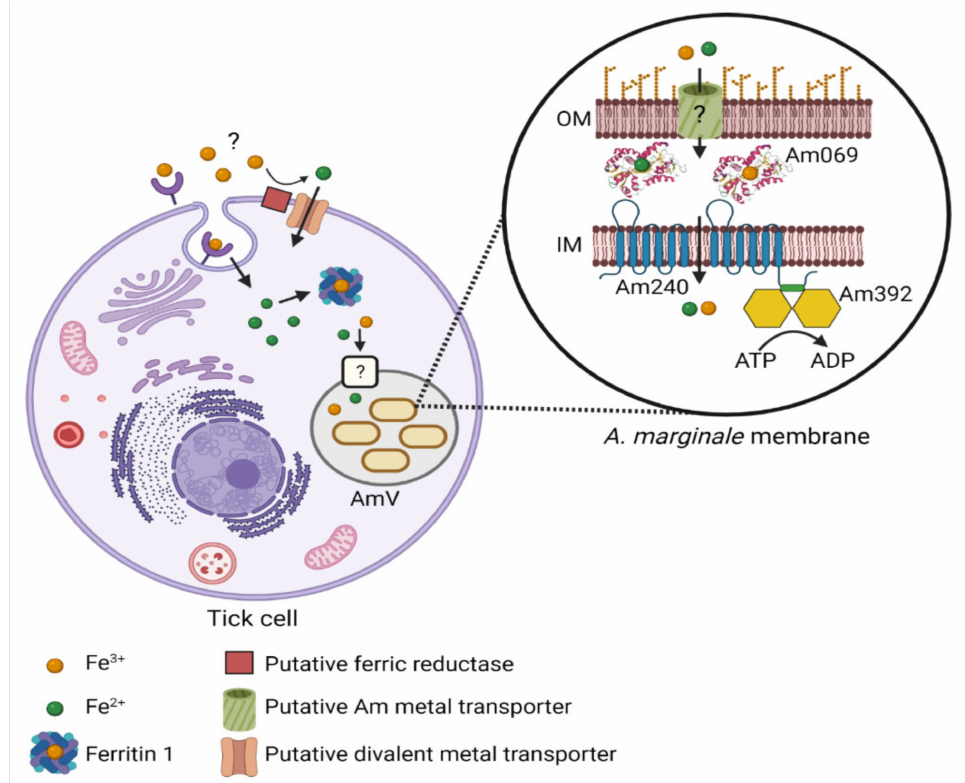
Figure 8. Knowledge gaps in understanding iron transport in tick cells and A. marginale . Molecules and mechanisms required for uptake of dietary iron in tick cells and transport of iron across the A. marginale -containing vacuole and A. marginale outer membrane are unknown and are denoted by “?” in the figure. Additionally, the requirement for Fe 2+ vs. Fe 3+ in iron transport in tick cells and A. marginale is unknown and is denoted by the use of both Fe 2+ and Fe 3+ in the diagram. Am069